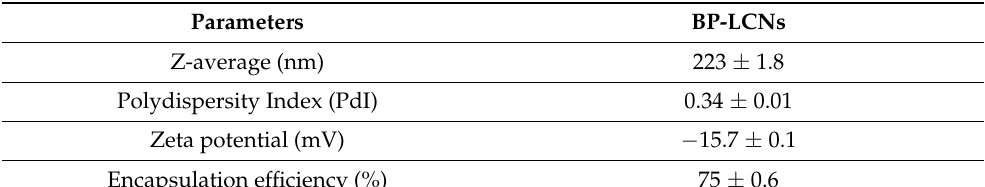
Table 4. Characterization parameters of BP-LCNs.